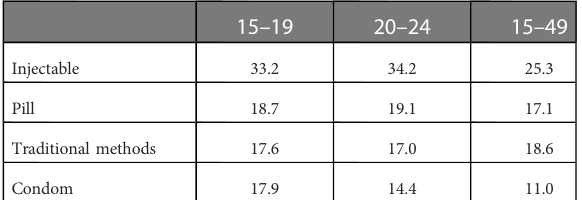
TABLE 3 Leading methods used by married women by age across all LMICs with available